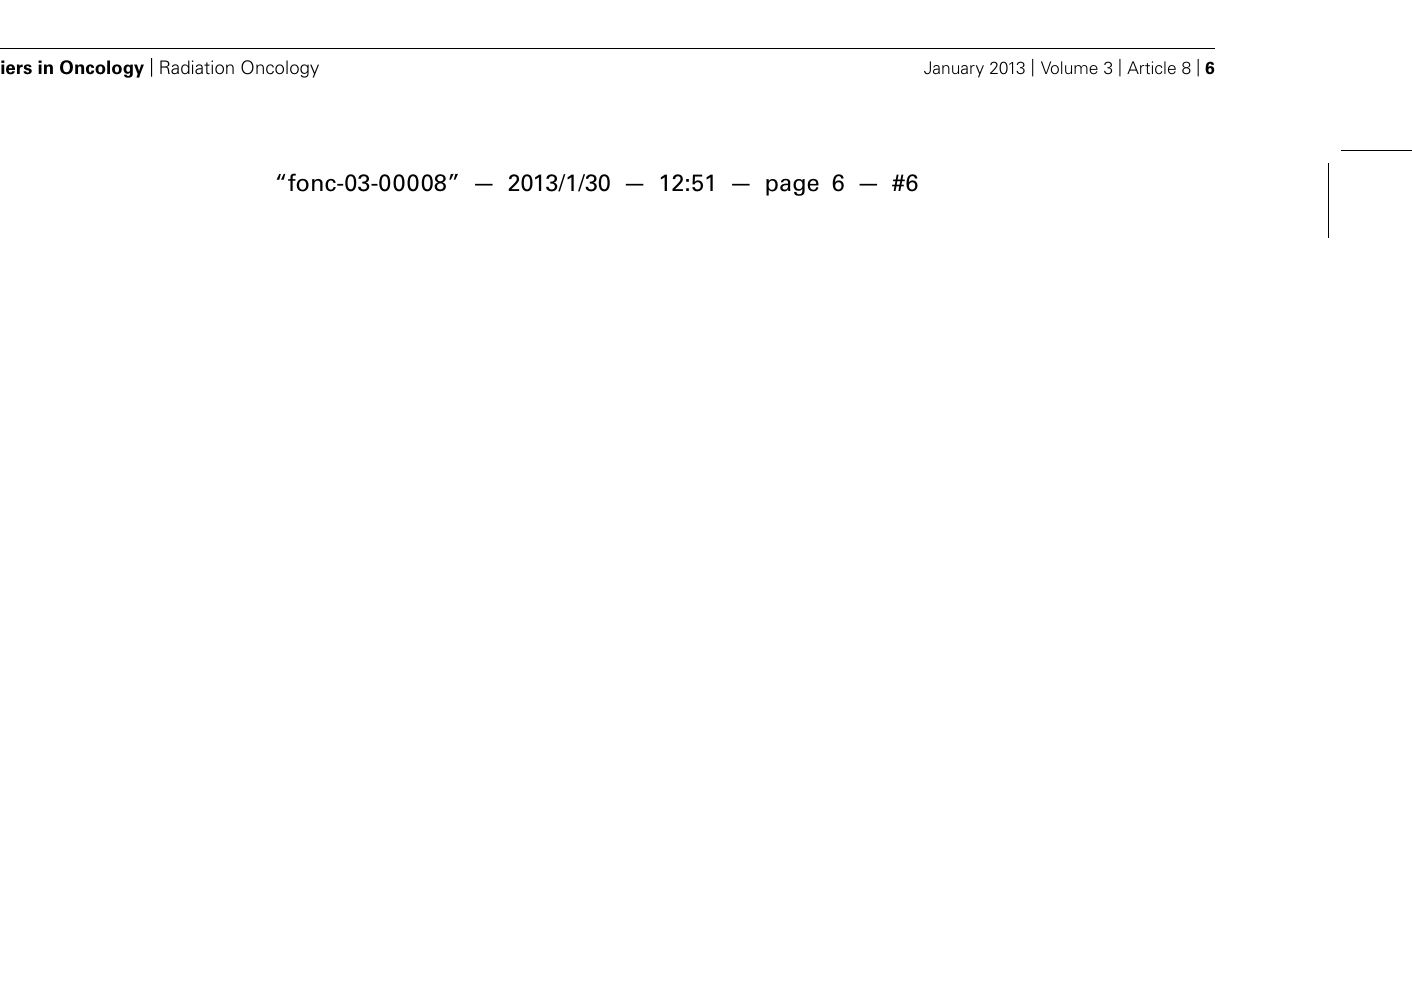
FIGURE 1 | Protein phosphatases regulate multiple phosphorylation events in the DNA damage response. (A) PP1, PP2A, andWip1 dephosphorylate ATM at S1981, which is required for the recruitment ATM to damage sites. BAAT1 protects ATM from dephosphorylation by phosphatases. PP5 is likely involved in ATM activation through dephosphorylation of ATM, which may induce ATM phosphorylation at S1981. (B) PP5 is required for ATR- targeted phosphorylation of Rad17 and Chk1. Although PP5 associates with ATR in a DNA damage-dependent manner, the